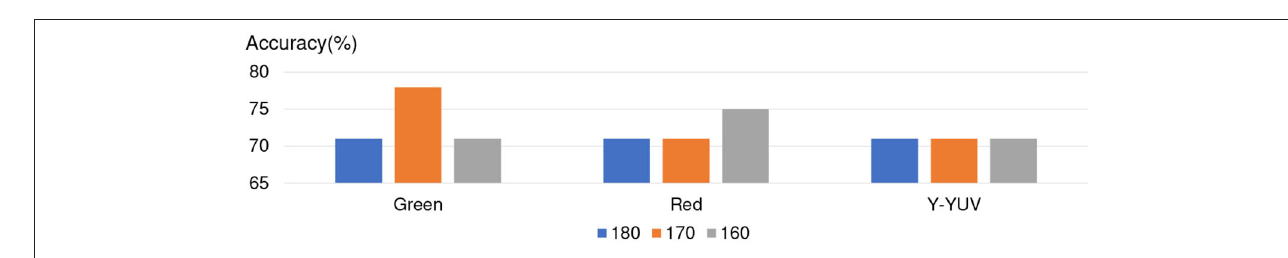
FIGURE 8 | Discussion about Ensemble model.